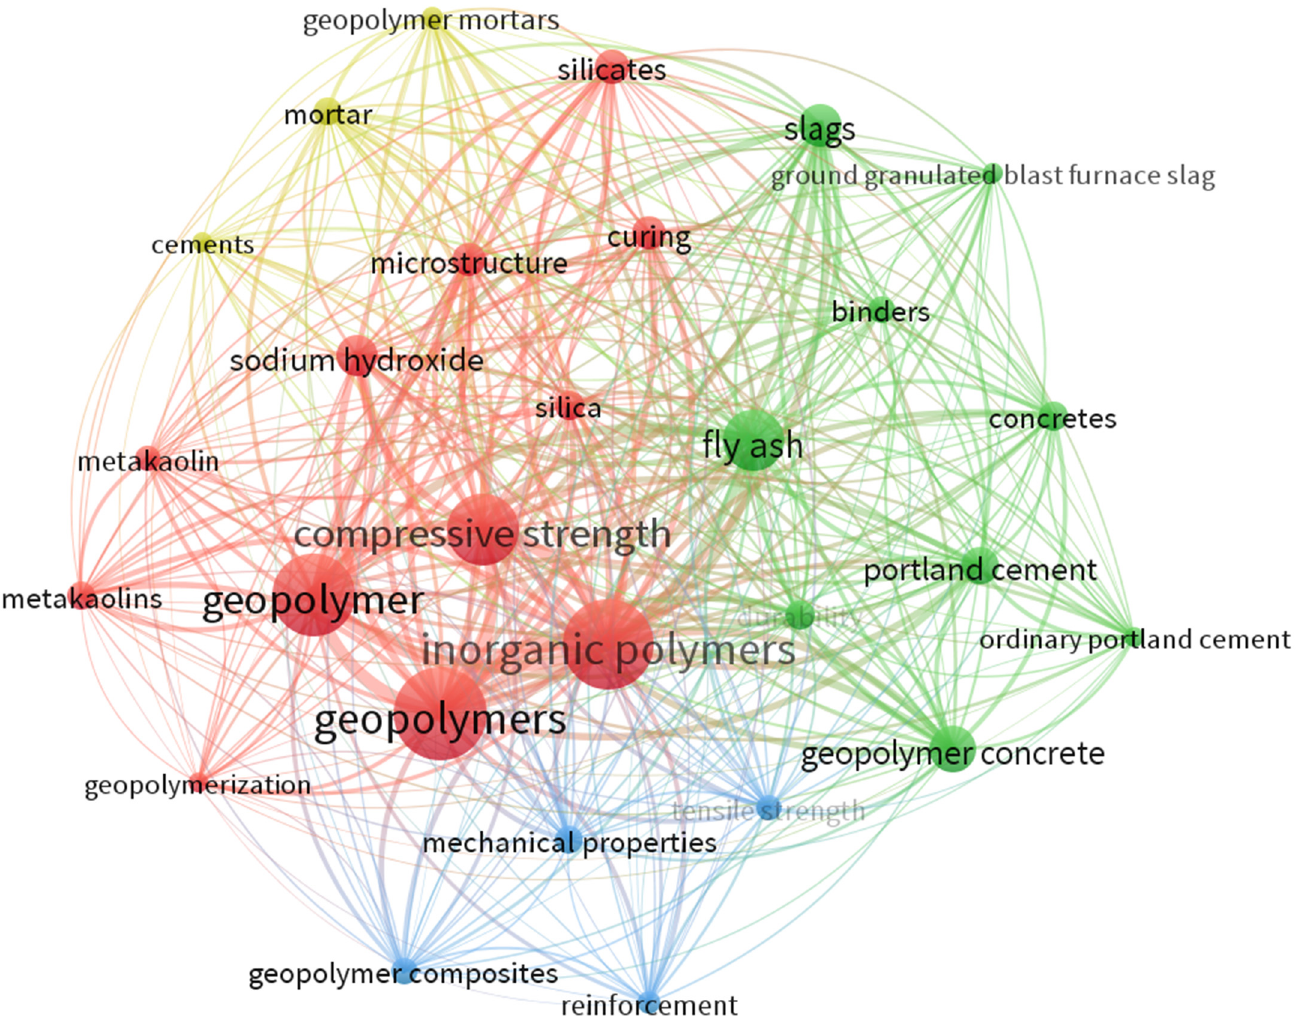
Figure 3. Network visualization of keyword co-occurrence.